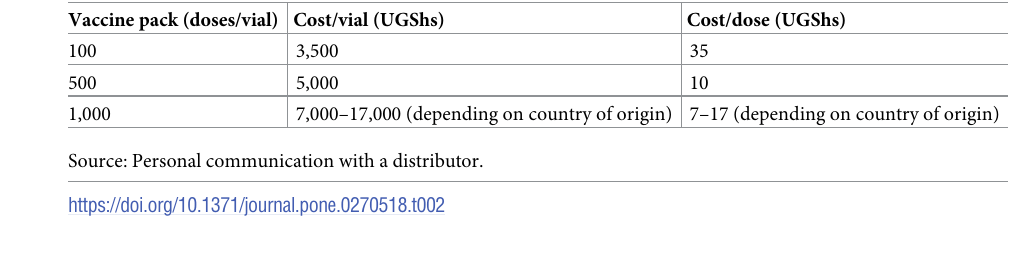
Table 2. Cost of new castle disease